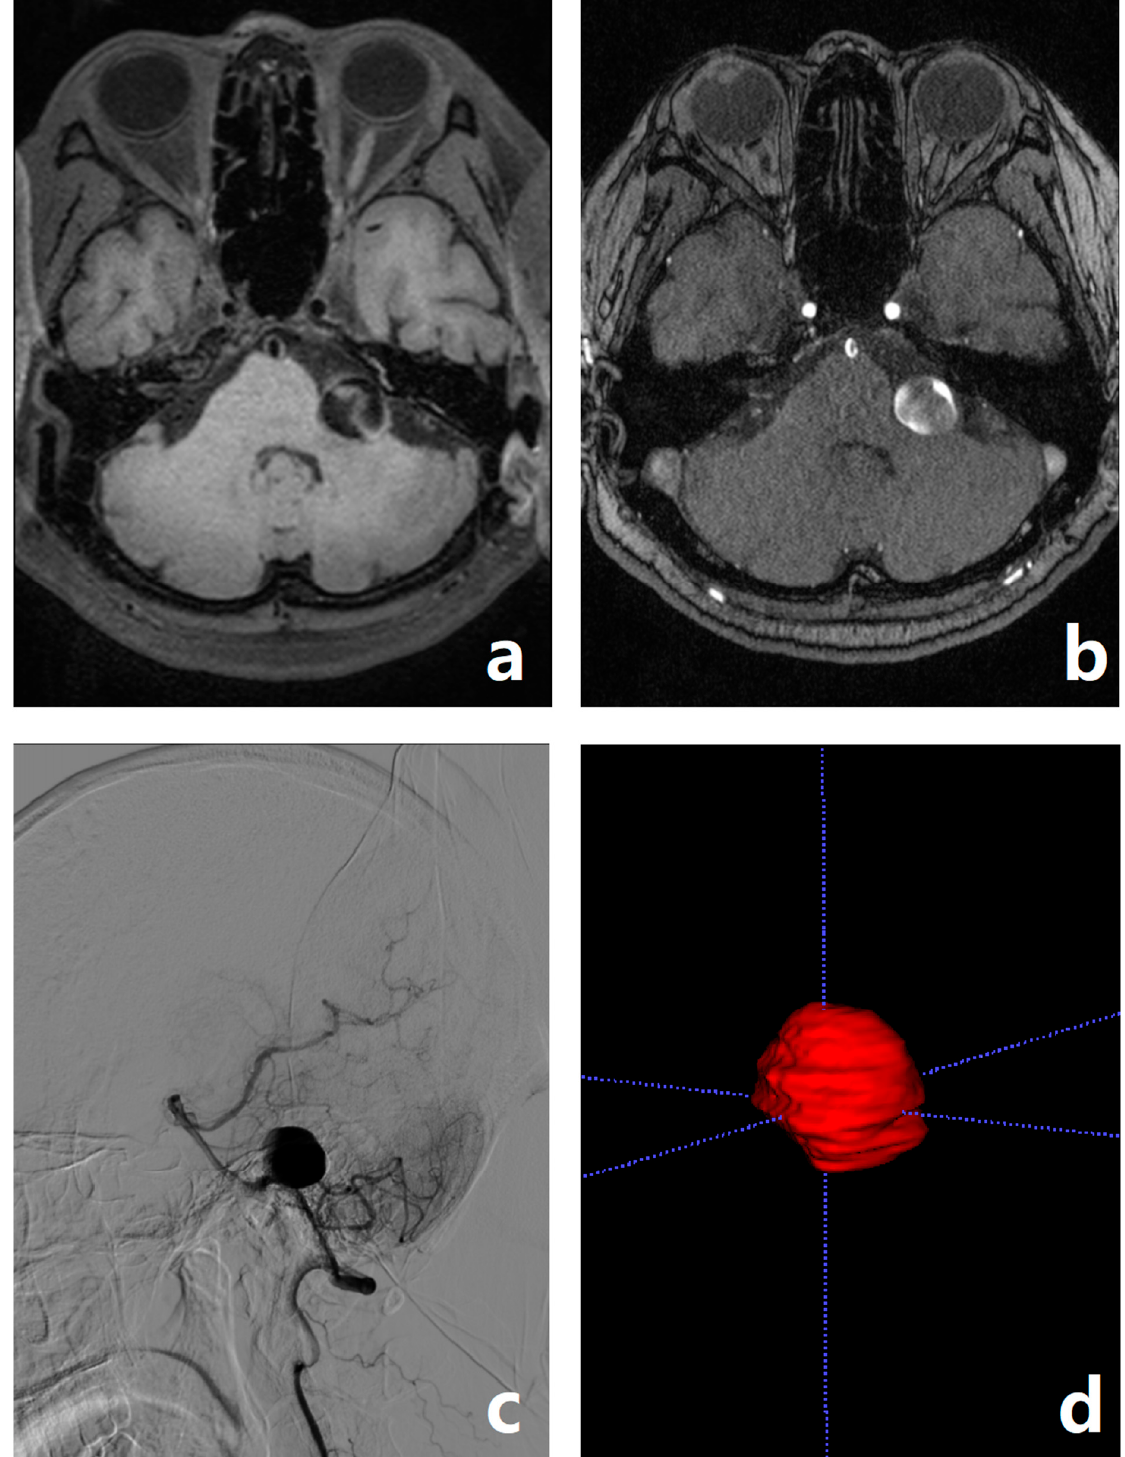
Figure 4. A 64 year old female who had headache and nausea for two weeks. The radiologist diagnosed a DA in the V4 segment of her left vertebral artery. There are double lumen and sign resembling the intimal flap in the aneurysm on 3D T 1 WI ( a ). TOF-MRA shows inhomogeneous signal within the aneurysm ( b ). DSA finds no bleeding site or intimal tear hole ( c ). Her 3D volumetric reconstruction of the ROI ( d ). The radiomic model diagnoses it as an SA, which is consistent with the surgical